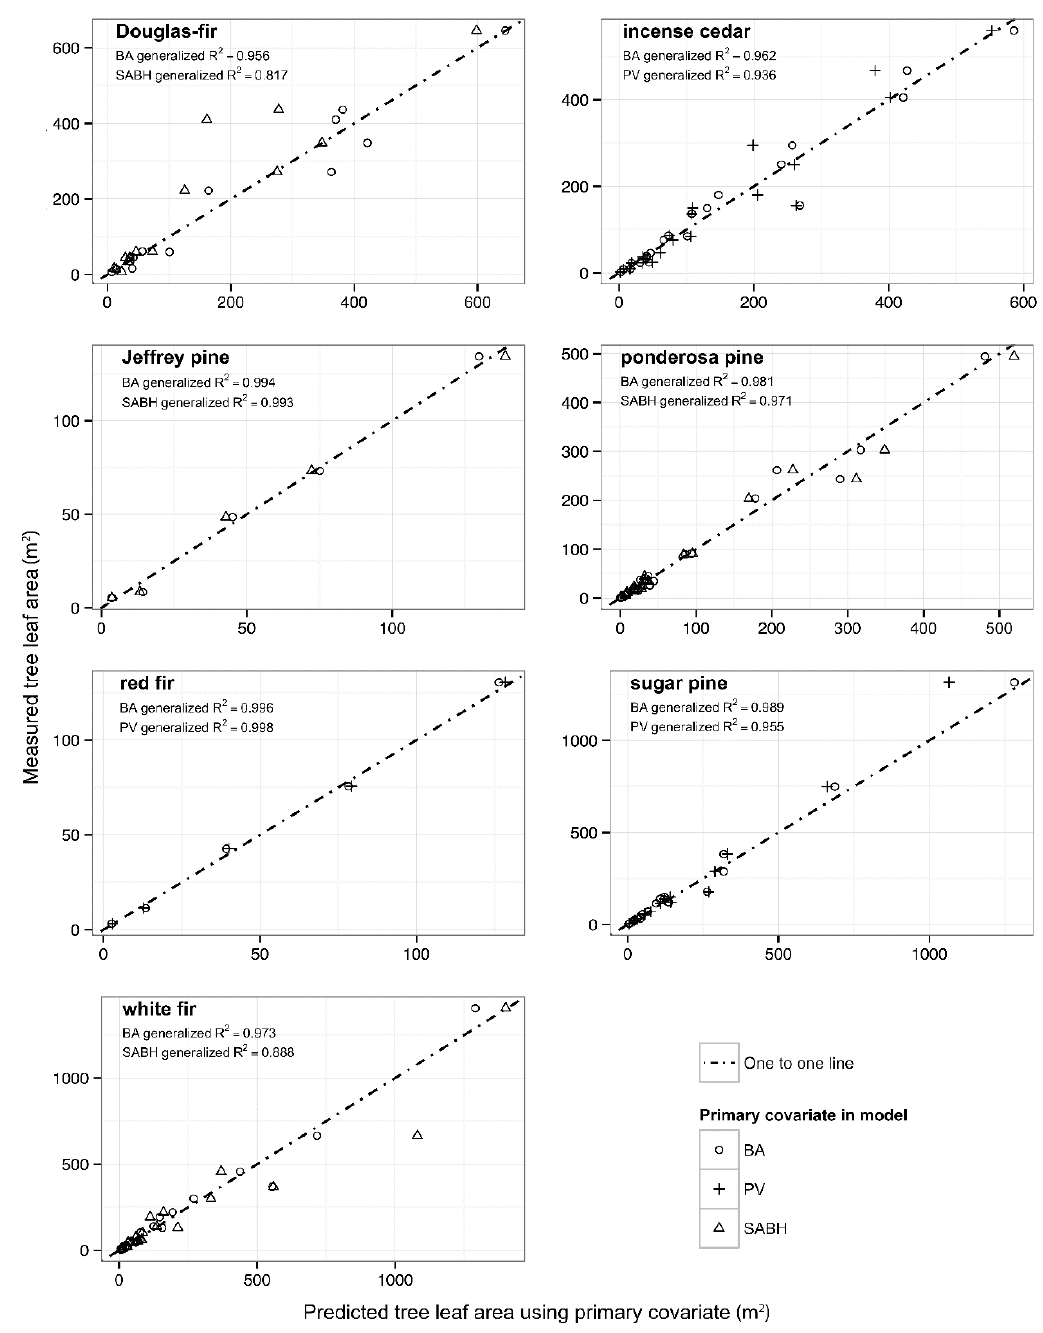
Figure 3. Whole tree leaf area as a function of predicted leaf area from two best-fit functions for seven conifer species. Generalized R 2 model fits for top two primary covariates are shown as well one-to-one lines to indicate scatter around theroetical line of perfect fit. The best-fit prediction model for whole tree leaf area was model 19 with basal area as the primary covariate for Douglas-fir, incense-cedar, Jeffrey pine, and red fir. White fir and ponderosa pine had the lowest AIC fits with model 12 and cross-sectional sapwood area as the primary covariate. The best-fit model for sugar pine was model 13 with the parabolic volume as the primary covariate. Parameter estimates for all species and best-fit models including additional covariates can be found in Table 7. Model 19 fits are also included for each species in Table 7 as this model had the best overall